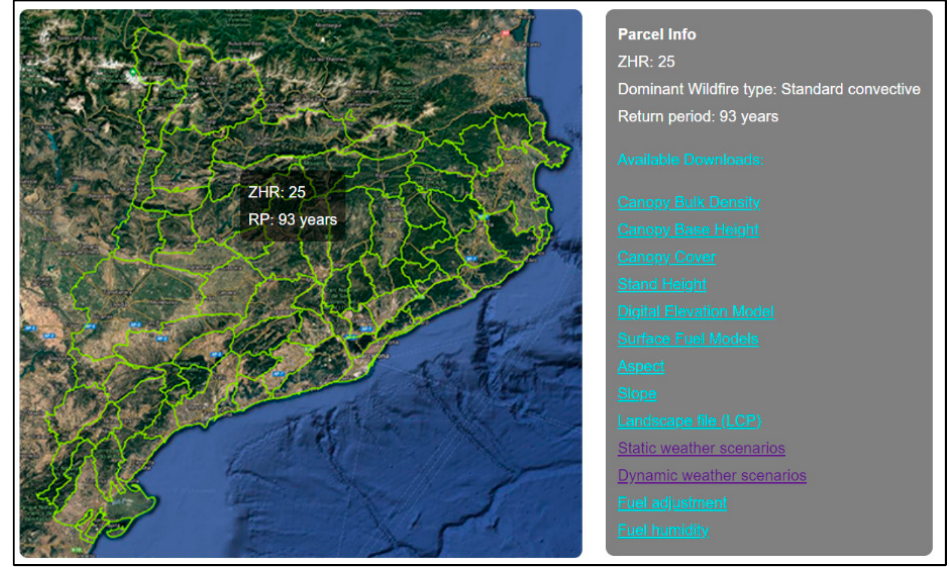
Figure 7. Interface of PREVINCAT server with all available data layers spatially structured by 77 Zones of Homogeneous Fire Regime (ZHR) [69].